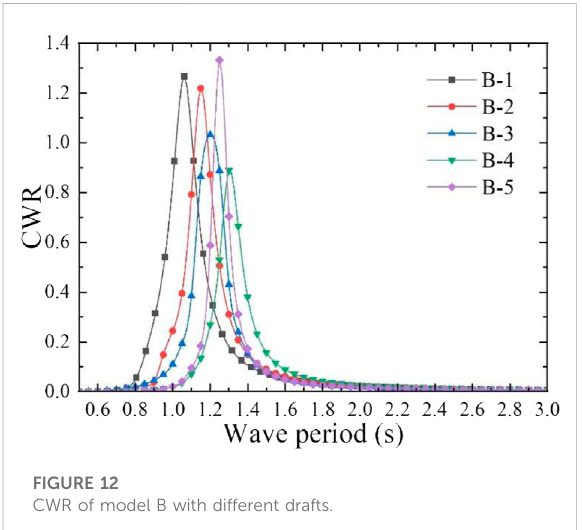
FIGURE 12 CWR of model B with different drafts.